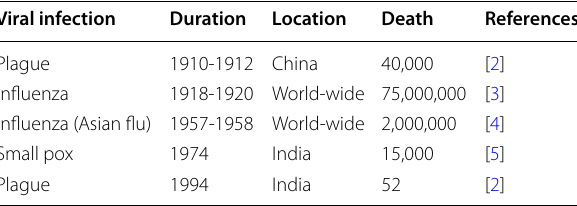
Table 1 Few major epidemic/pandemic of viral infections in 20 th century